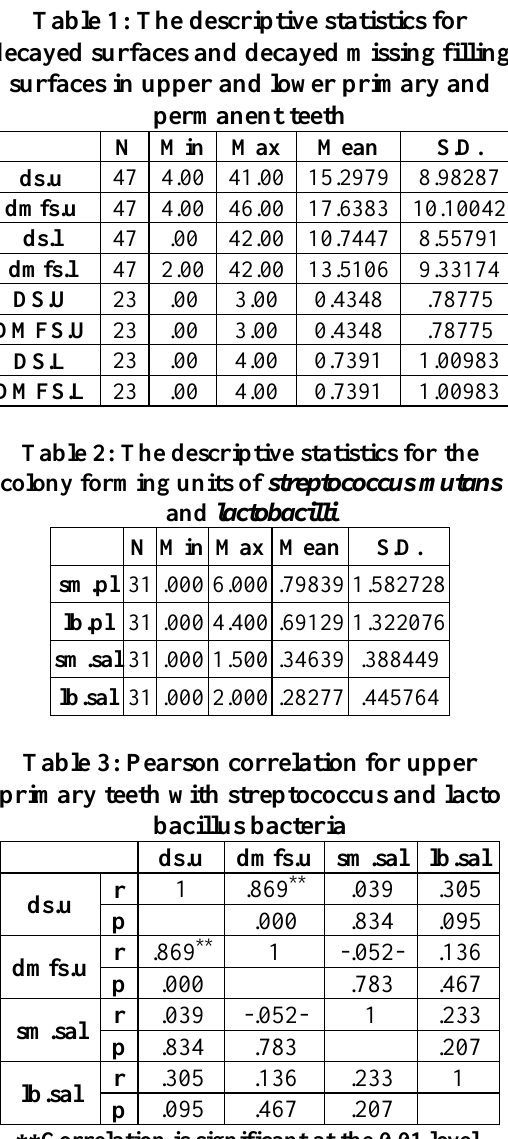
Table 4: Pearson correlation for lower